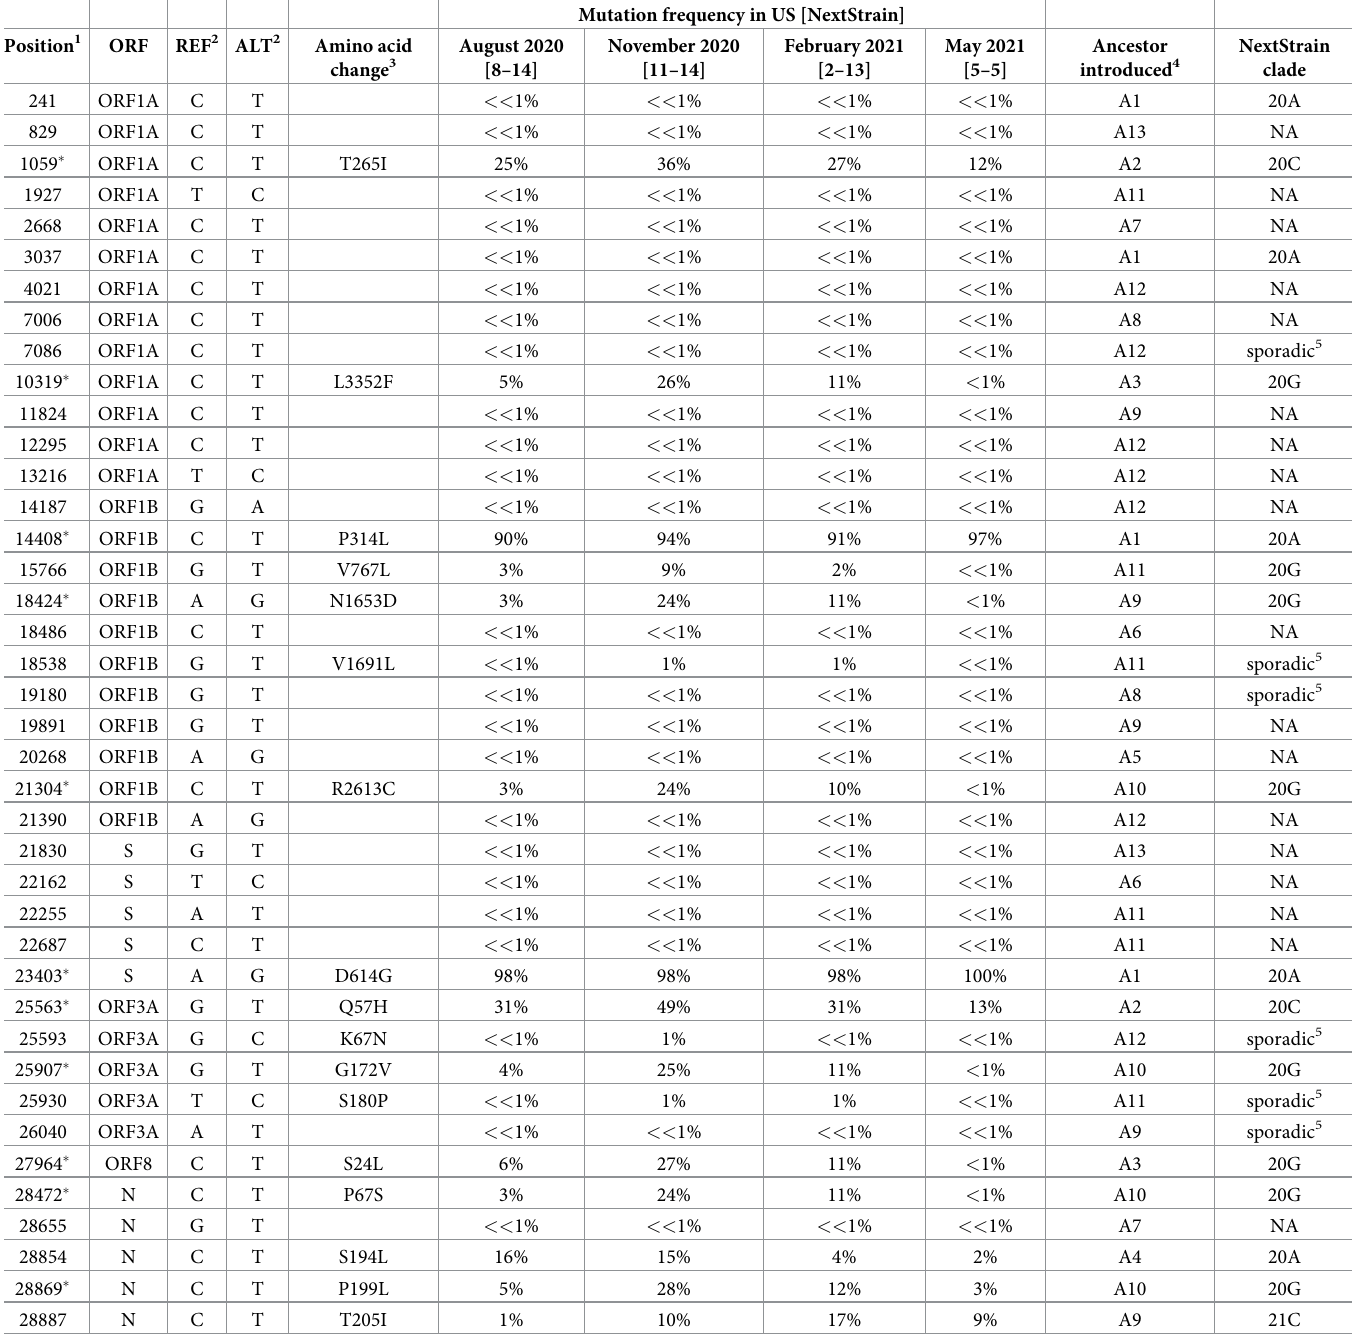
Table 1. Lineage-defining mutations in a set of 44 Colorado SARS-CoV-2 genomes.